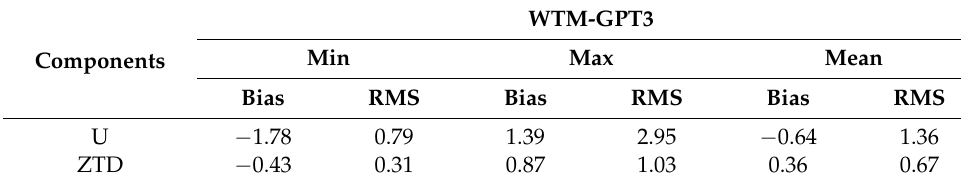
Table 5. Coordinate and ZTD differences (mm) between the two PPP schemes.